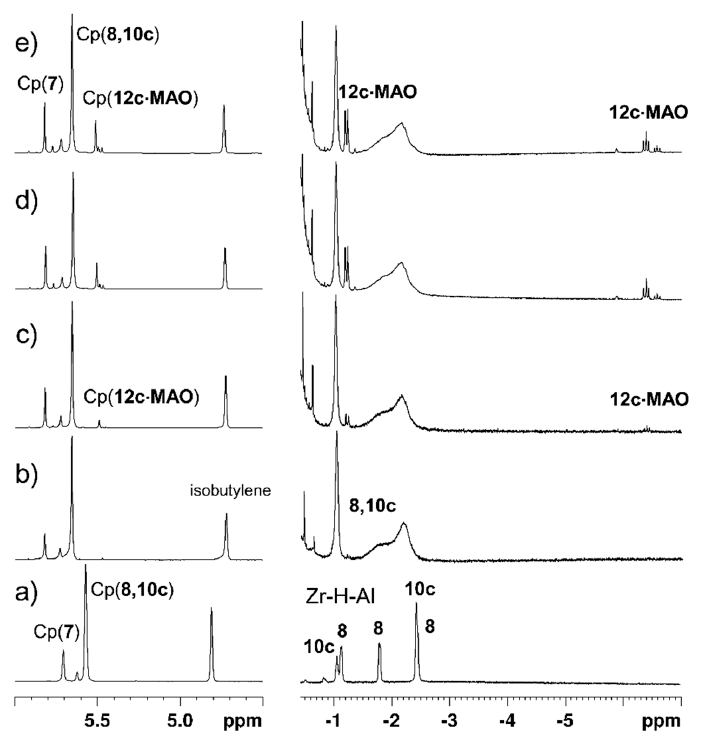
Figure 1. 1 H NMR of system Cp 2 ZrCl 2 -AlBu i3 -MMAO-12 in С 7 D 8 (T = 25 °C, intensity of upfield signals